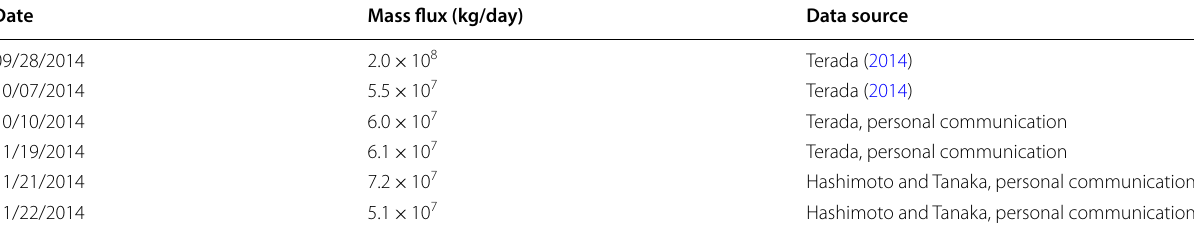
All estimates are based on plume rise method (Kagiyama